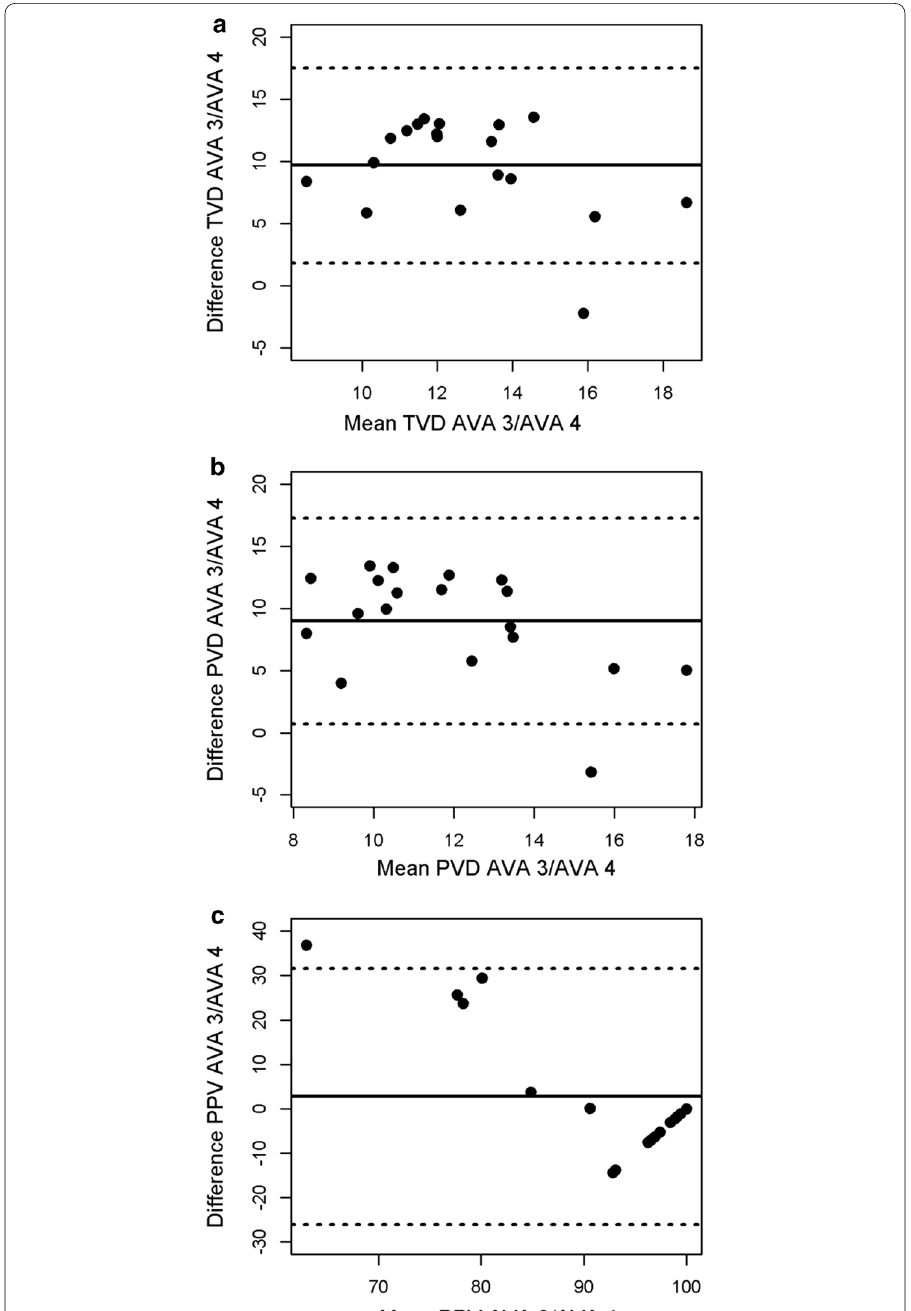
Fig. 3 V1 dataset Bland–Altman plots for total vessel density ( a ), perfused vessel density ( b ) and proportion of perfused vessels ( c ). The x -axis shows the mean of the two measurement methods and the y -axis shows their difference. The mean difference is represented by the solid line and the dashed lines represent the limits of agreement, equivalent to 1.96 SD of mean ± 100%, whereas PPV values generated by AVA 3.2 had higher variability. The PPV Bland– Altman plots (Figs. 1c, 2c, 3c) therefore exhibit linear relationships for data points where